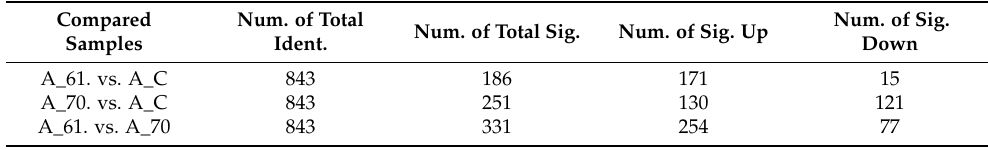
Table 8. Difference analysis results of metabolites.